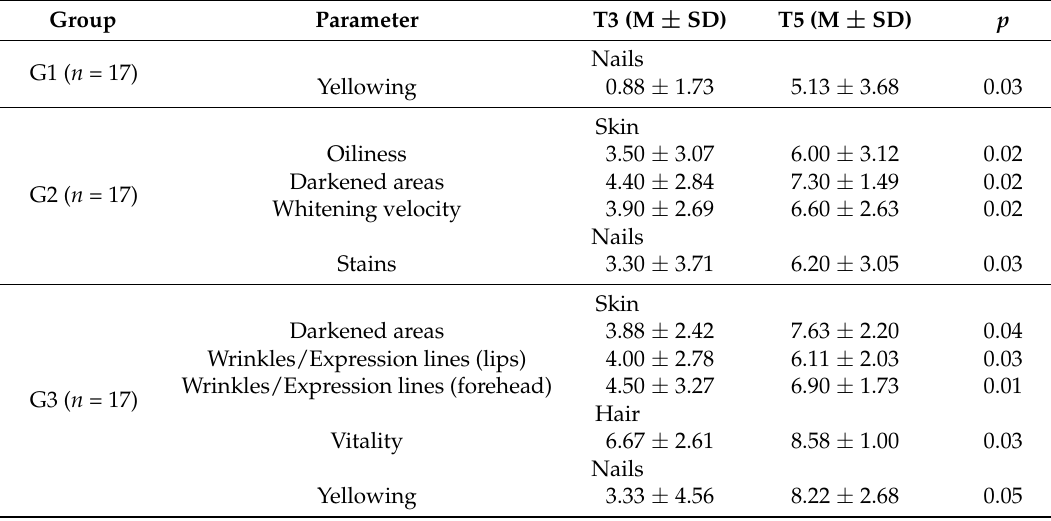
Table 2. Participants’ perception of changes in the skin, hair and nails after treatments (intra-group comparison).